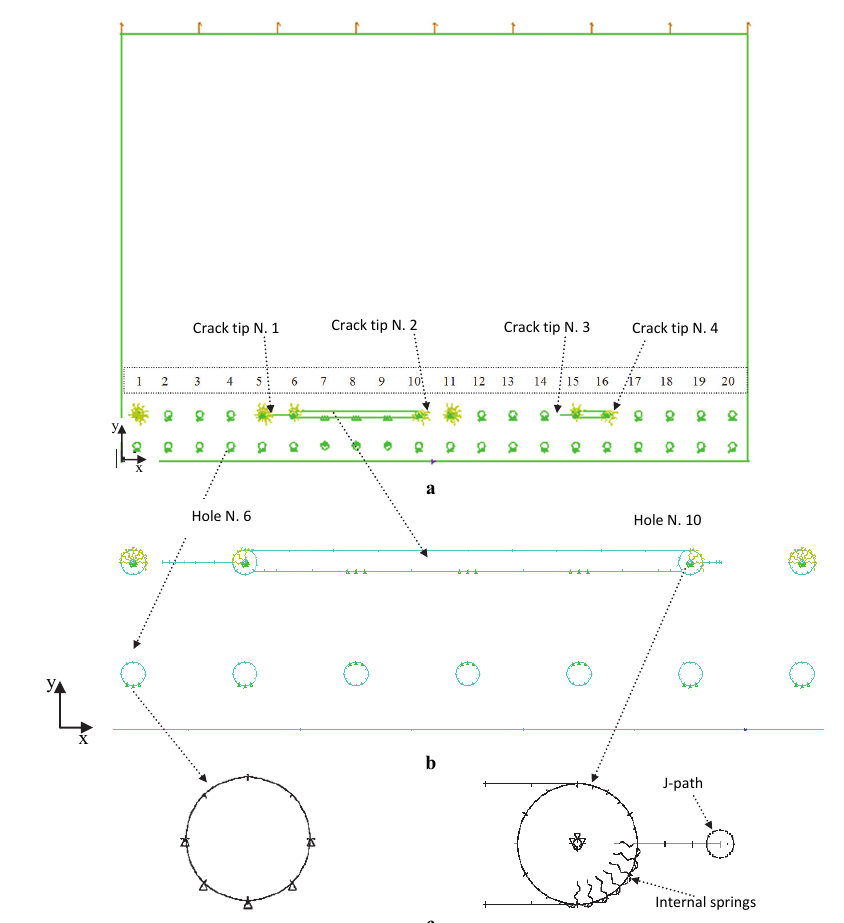
Figure 3: DBEM model of lap-joint in the proposed initial cracked configuration, with highlight of: hole numbering on the cracked raw (a); main crack (b); hole constraints, rivets, J-path around the crack tip and “internal springs” (c).